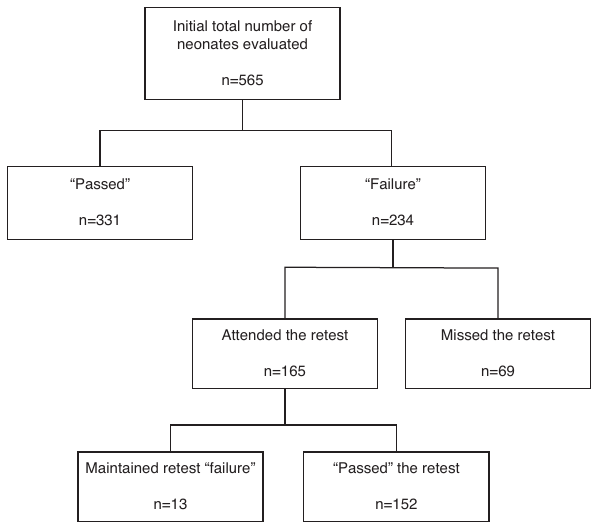
Flowchart of patients seen during the study period ( n , number).